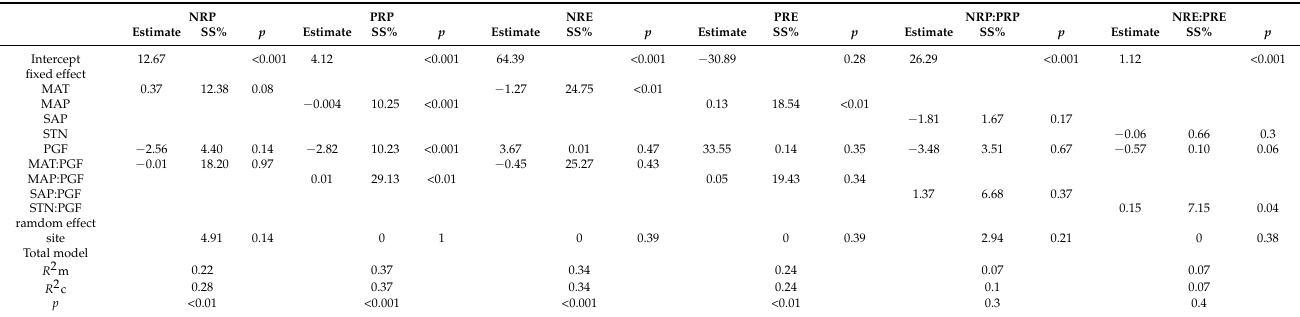
Table 2. Results of linear mixed-effects models for leaf N and P resorption traits.